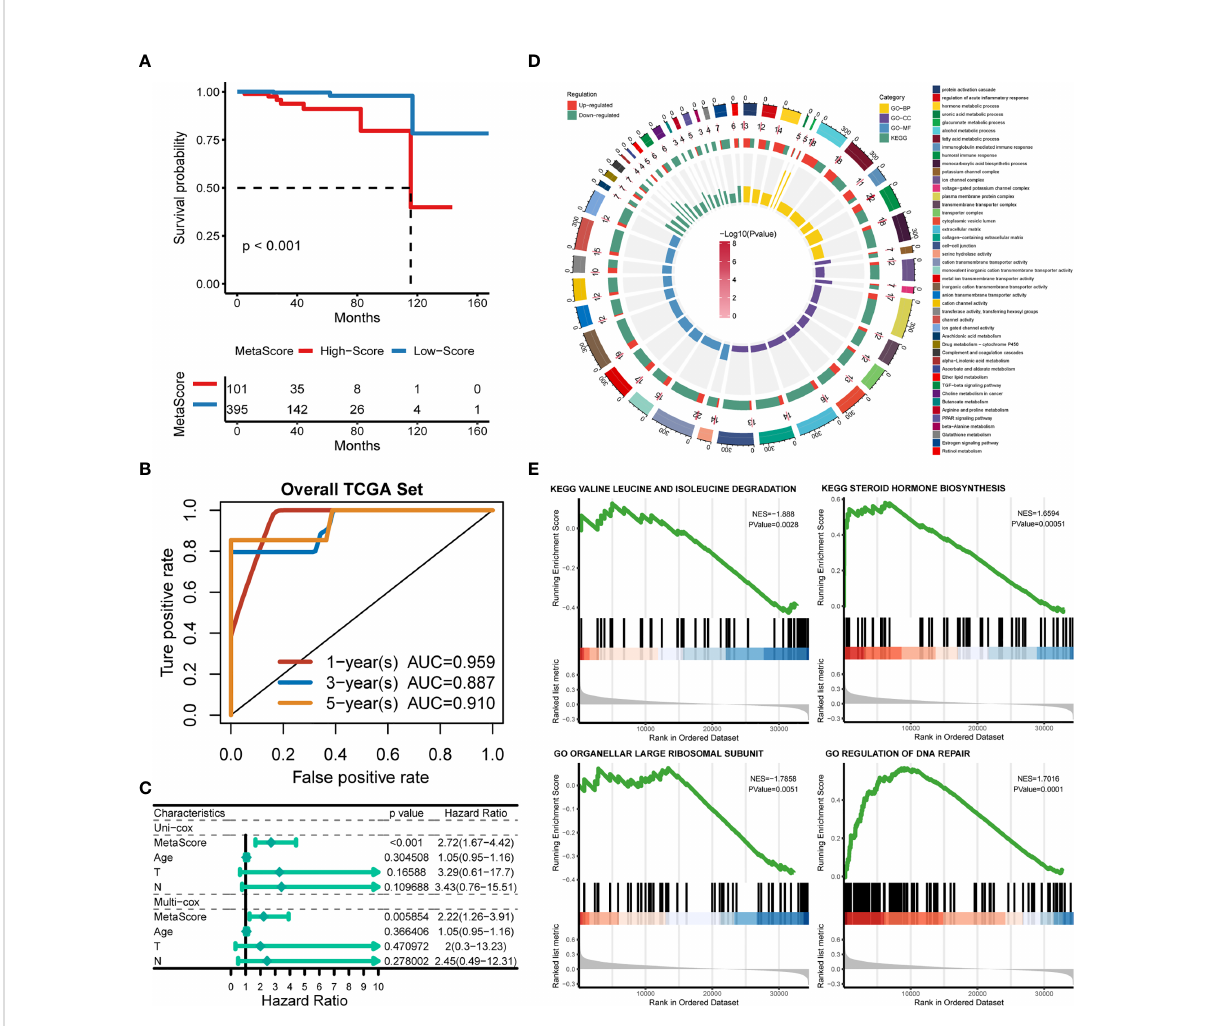
FIGURE 3 Functional annotation of low- and high-MetaSore groups. (A) Kaplan – Meier curves showing the correlation between MetaScore and OS (log- rank test, p < 0.001). (B) ROC curves exhibited the predictive capability of the MetaScore signature on the clinical value including 1-, 3- and 5- year. (C) Clinical variables related to OS by univariate cox and multivariate cox analysis in the TCGA-PRAD cohort. (D) GO and KEGG plots for enrichments based on the high- and low-MetaScore group. (E) GSEA plots for enrichments based on the high- and low-MetaScore